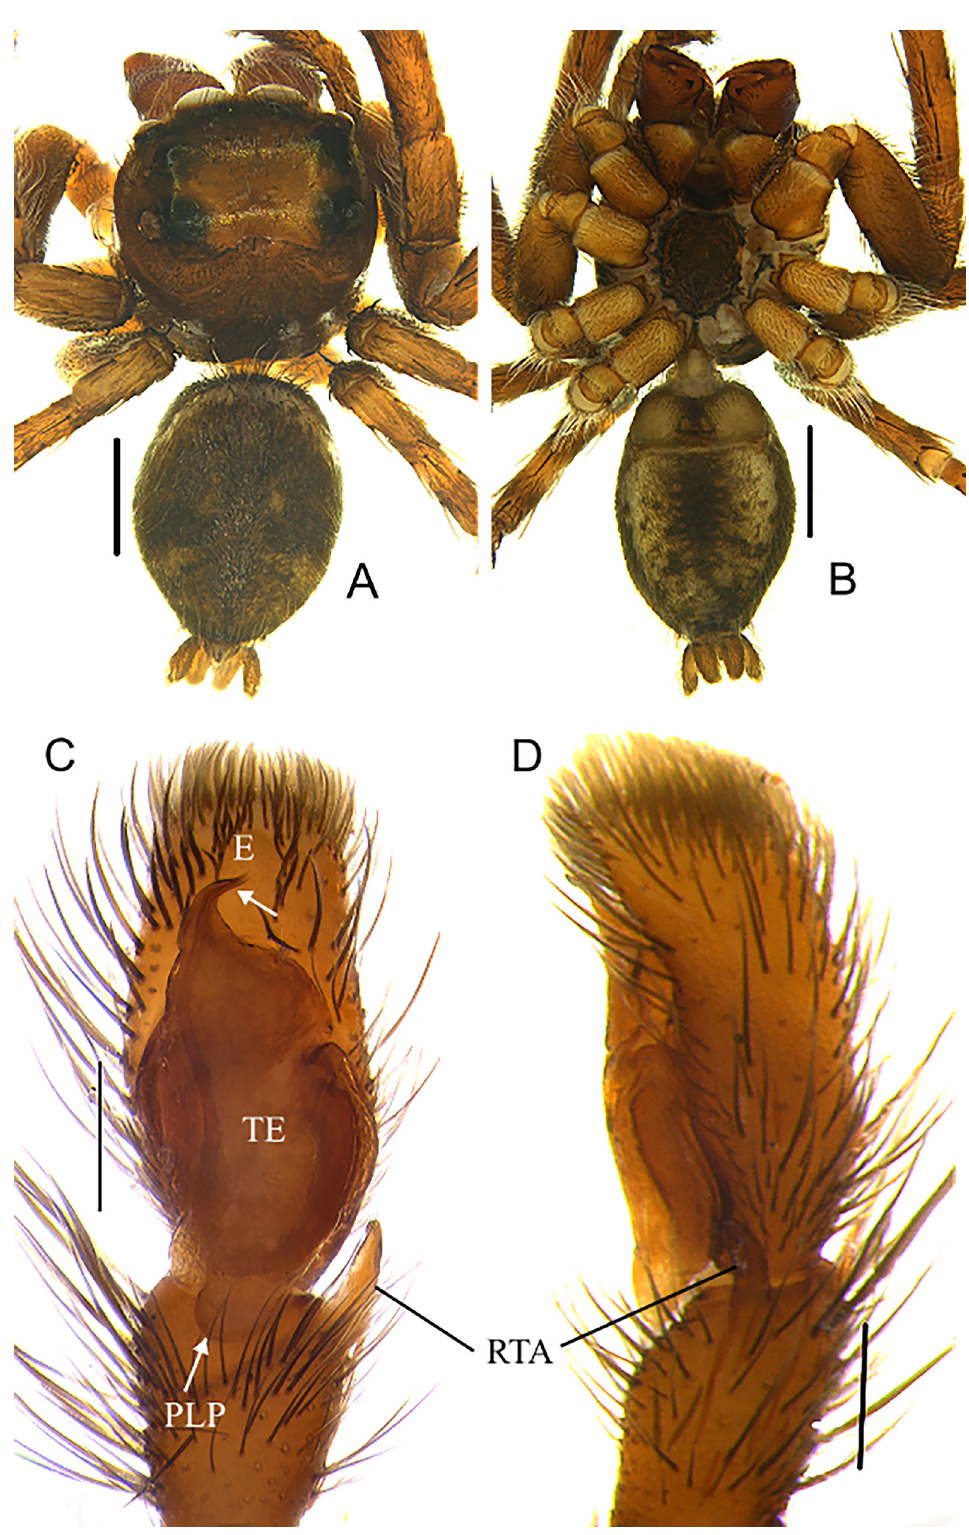
Fig 8. Carrhotus lobatus sp. nov. A–B . Male habitus. A . Dorsal view. B . Ventral view. C–D . Palp, C . Ventral view. D . Retrolateral view. Abbreviations: E = embolus; PLP = posterior lateral protrusion; RTA = retrolateral tibial apophysis; TE = tegulum. Scale bars: A–B = 2 mm; C–D = 0.2